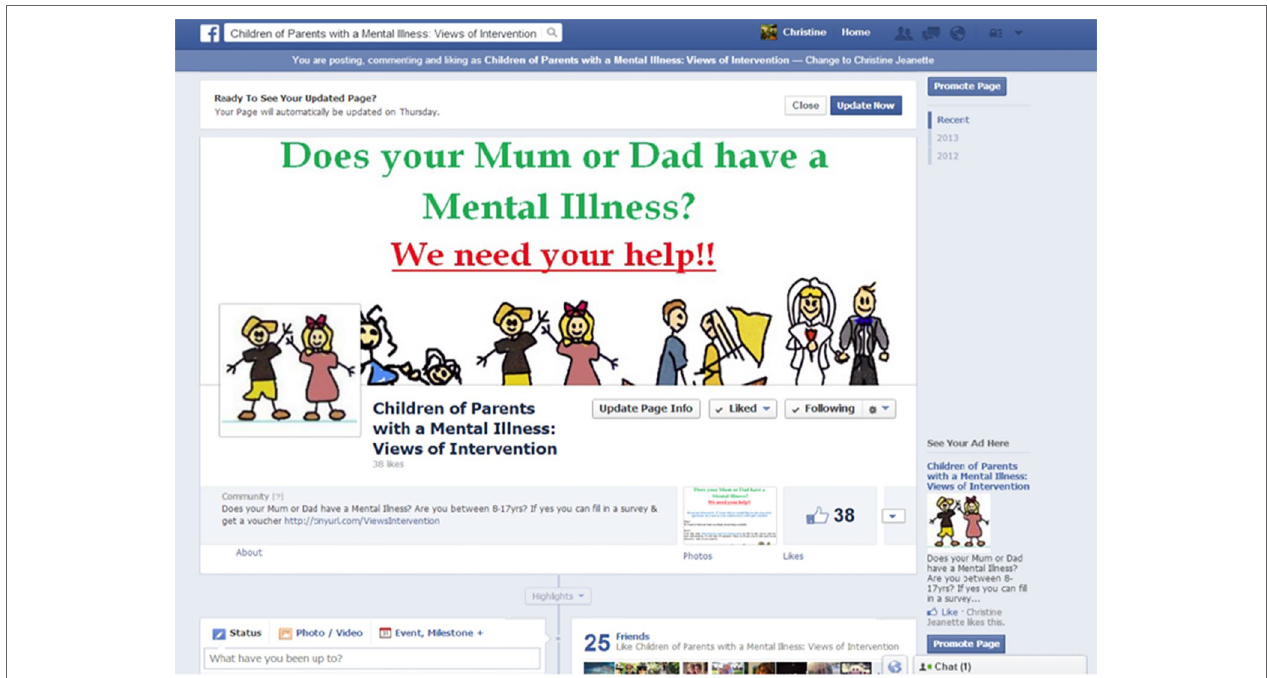
FIGURE 1 | Facebook research